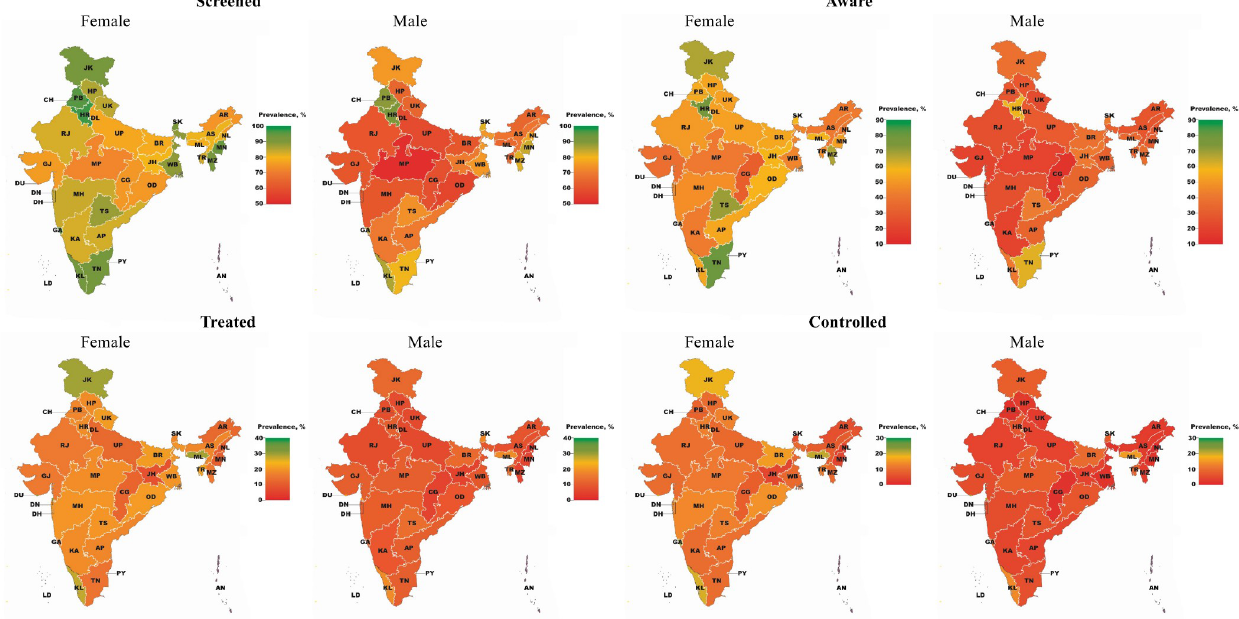
Fig 2. The hypertension care cascade by state. Union territories are included in the map but some are not visible due to their small size. Daman (DN) and Diu (DU) form one union territory together. Point estimates and 95% CIs for each state and union territory can be found in Tables D–H in S1 Supplemental Materials and, by sex, in Tables I–L in S1 Supplemental Materials. AN, Andaman and Nicobar Islands; AP, Andhra Pradesh; AR, Arunachal Pradesh; AS, Assam; BR, Bihar; CG, Chhattisgarh; CH, Chandigarh; DH, Dadra and Nagar Haveli; DL, Delhi; DN, Daman; DU, Diu; GA, Goa; GJ, Gujarat; HP, Himachal Pradesh; HR, Haryana; JH, Jharkhand; JK, Jammu and Kashmir; KA, Karnataka; KL, Kerala; LD, Lakshadweep; MH, Maharashtra; ML, Meghalaya; MN, Manipur; MP, Madhya Pradesh; MZ, Mizoram; NL, Nagaland; OD, Odisha (Orissa); PB, Punjab; PY, Puducherry; RJ, Rajasthan; SK, Sikkim; TN, Tamil Nadu; TR, Tripura; TS, Telangana State; UK, Uttarakhand (Uttaranchal); UP, Uttar Pradesh; WB, West